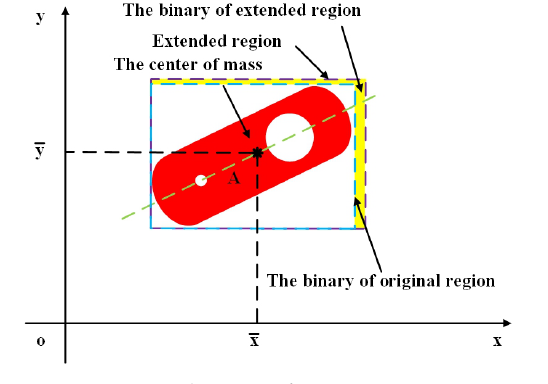
Figure 2. Schematic of image